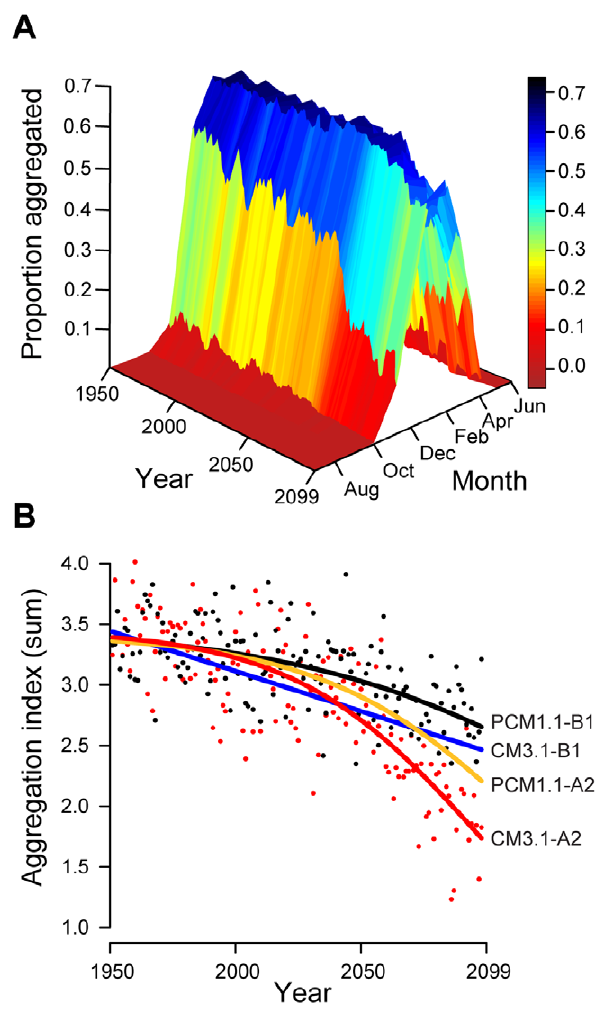
Figure 4. Predicted changes in night lizard aggregation under projected climate scenarios. ( A ) Proportion of the population predicted to aggregate under a climate projection model (CNRM CM3.1-A2). Over time, this proportion decreases both in peak magnitude and in number of months per year with high levels of aggregation. ( B ) Sum of monthly aggregation proportions by year (aggregation index) under two climate models (CNRM CM3.1 and NCAR PCM1.1) and two emissions projections (A2 and B1). Predicted aggregation declines by 20% under mild climate projections and more than 50% under more severe projections (four model mean=33%). Points generating the curves are shown only for the two most disparate